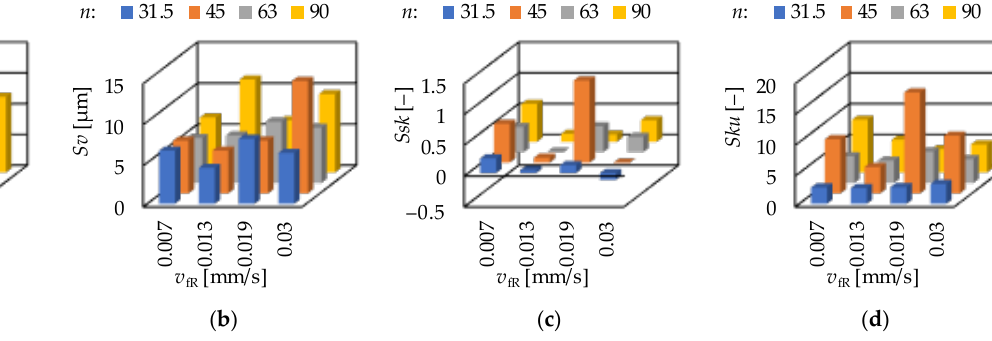
Figure 12. The measured ( a ) maximum peak height— Sp ; ( b ) maximum valley depth— Sv ; ( c ) skewness— Ssk and ( d ) kurtosis— Sku values for grinding. When the rpm is fixed at 31.5 1/min, the smallest arithmetic mean height ( Sa ) was obtained at 0.0302 mm/s. The smallest values of maximum height ( Sz ), peak material volume ( Vmp ), valley void volume ( Vvv ), maximum peak height ( Sp ) and maximum valley depth ( Sv ) were obtained at 0.0130 mm/s. When the rpm is fixed at 63 1/min, the smallest